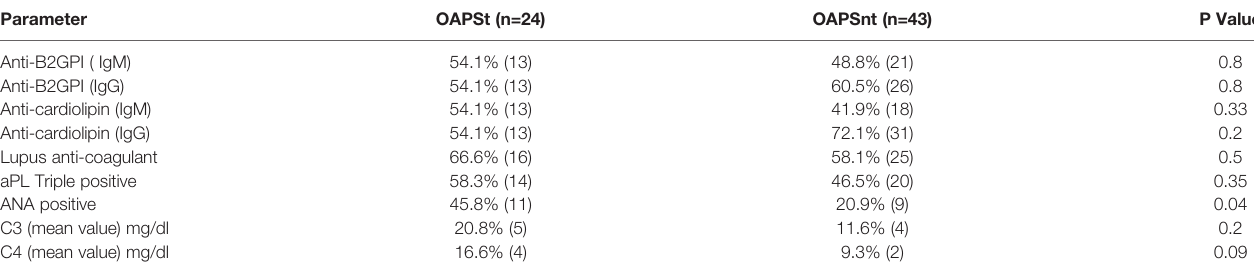
TABLE 4 | Serological Clinical parameters of OAPS patients with thrombosis (OAPSt) and without thrombosis during follow up (OAPSnt).